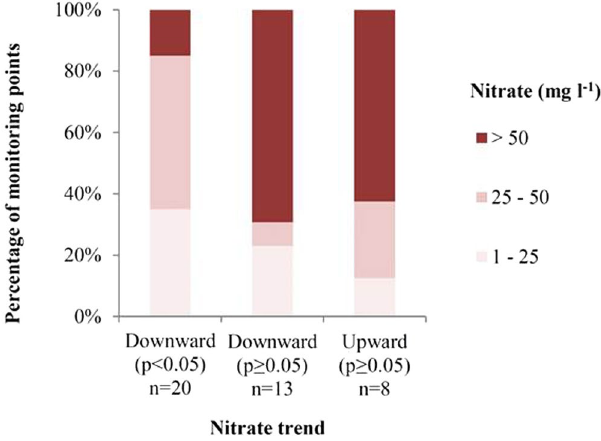
Figure 3. Latest measured nitrate concentration (2014) illustrated in three oxic groundwater nitrate classes ( > 50 mg l − 1 , 25–50 mg l − 1 and 1–25 mg l − 1 ) grouped according to the nitrate trends in the groundwater infiltration period P4: